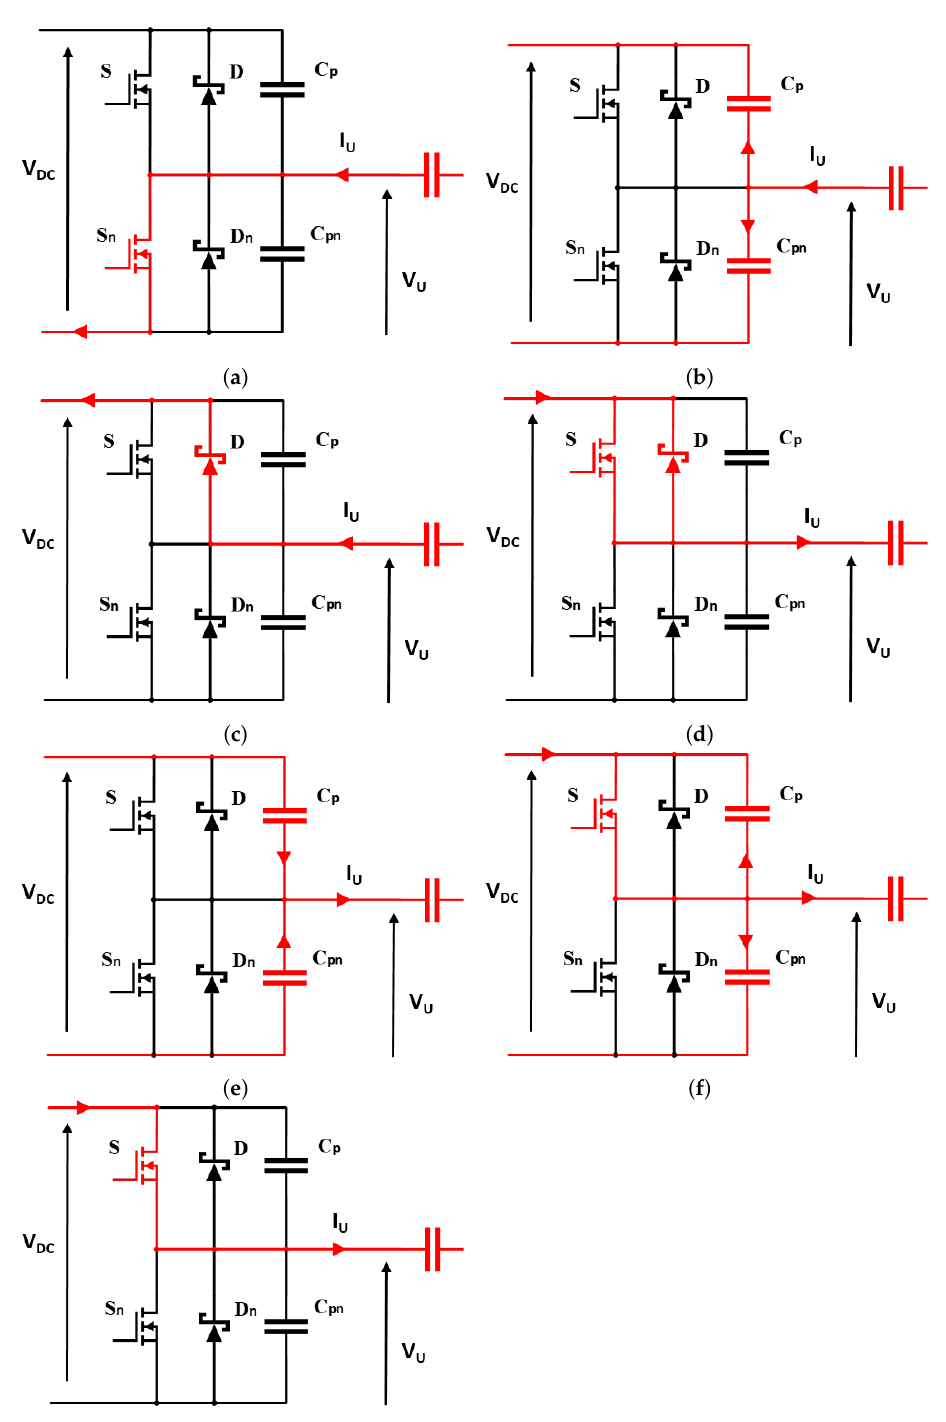
Figure 13. Current paths during the commutation reaching